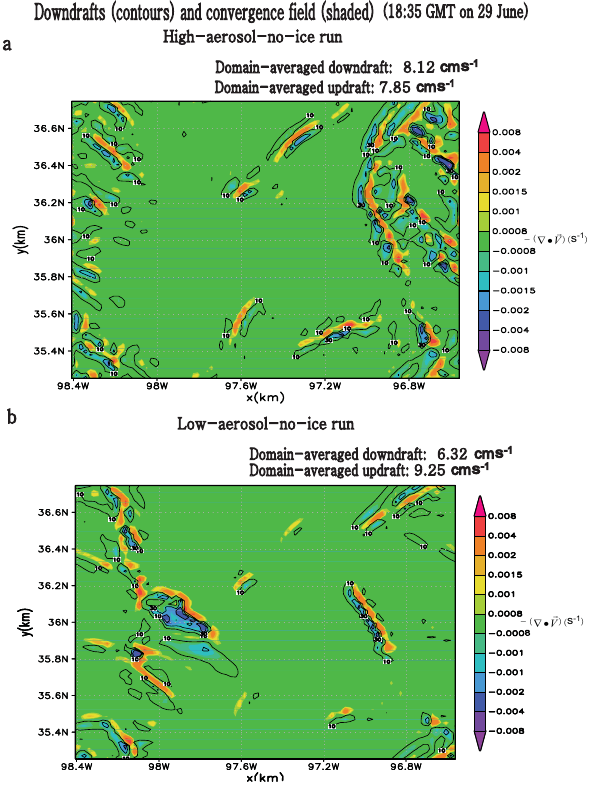
Fig. 8. (a) and (b) are the superimposition of convergence field (s − 1 ) at the surface (represented by shading) and the averaged up- drafts over the lowest 4km (represented by contours for 50, 100, and 200 (cms − 1 )) at 19:15GMT on 29 June for the high-aerosol- no-ice run and the low-aerosol-no-ice run in DEEP, respectively. (cid:12) (cid:12) •−→ (cid:12) (cid:12) ∇ V For reference, domain-averaged (cid:12) (cid:12) over the lowest 1km and updrafts over the lowest 4km are shown just above (a) and (b). −→ V is the horizontal wind Here,